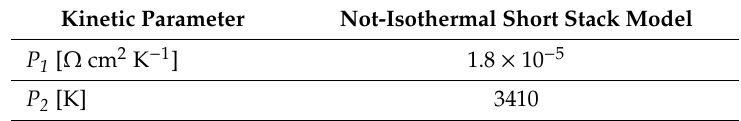
Table 4. Kinetics parameters for a rSOC short stack operating in not-isothermal conditions.